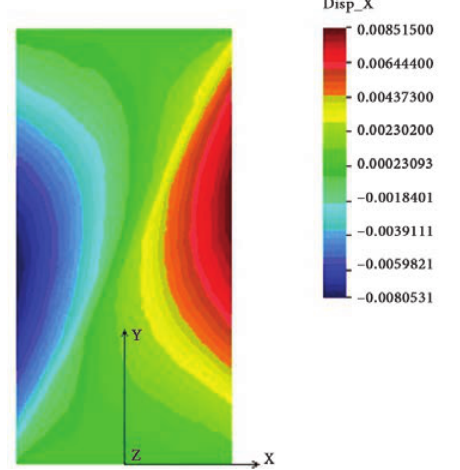
Fig. 8. Distribution of horizontal soil displacements u x in the sample with free